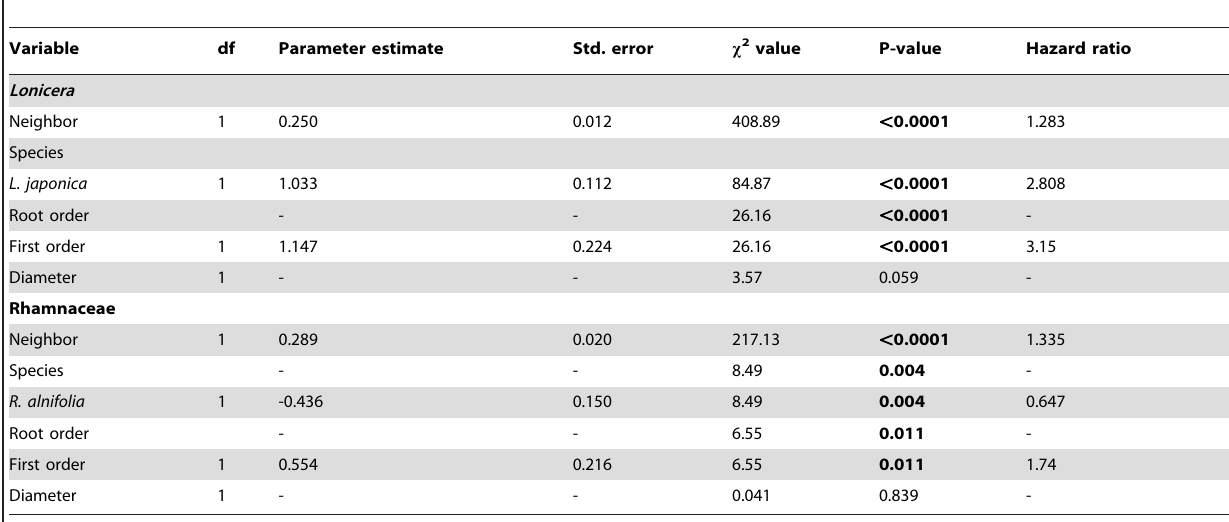
Table 2. Proportional hazards regression analysis results for root life span of congeneric natives ( L. sempervirens and R. alnifolia ) and non-natives ( L. japonica and F. alnus ).